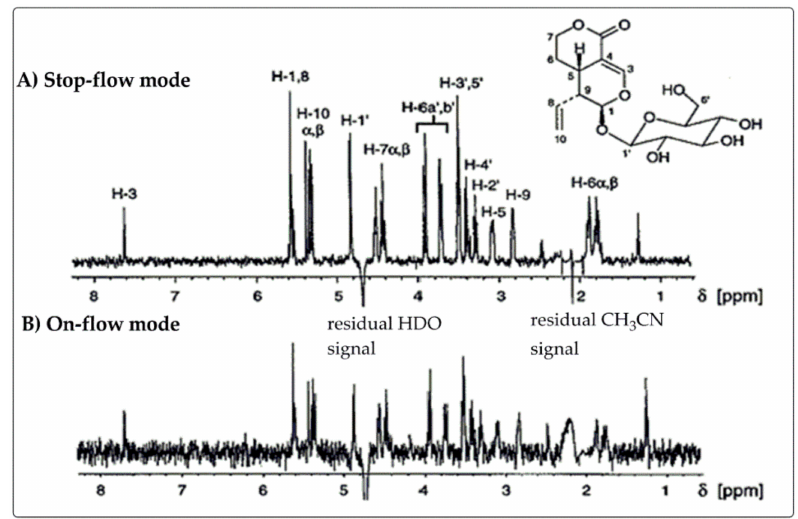
Figure 3. The comparison of stop-flow ( A ) and online-flow ( B ) modes of LC–1H–NMR spectra of sweroside in a dichloromethane extract of Swertia calycina depicting S/N ratio enhancement in stop-flow mode (reproduced from Ref. [1] with permission. Copyright © 1997, John Wiley & Sons,